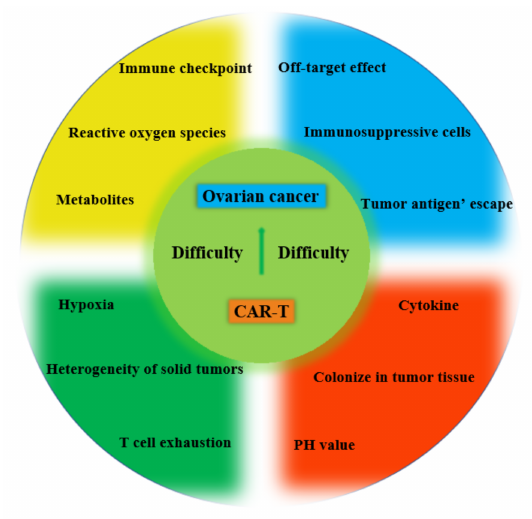
Figure 3. The challenges for CAR-T-cell therapy for the treatment of